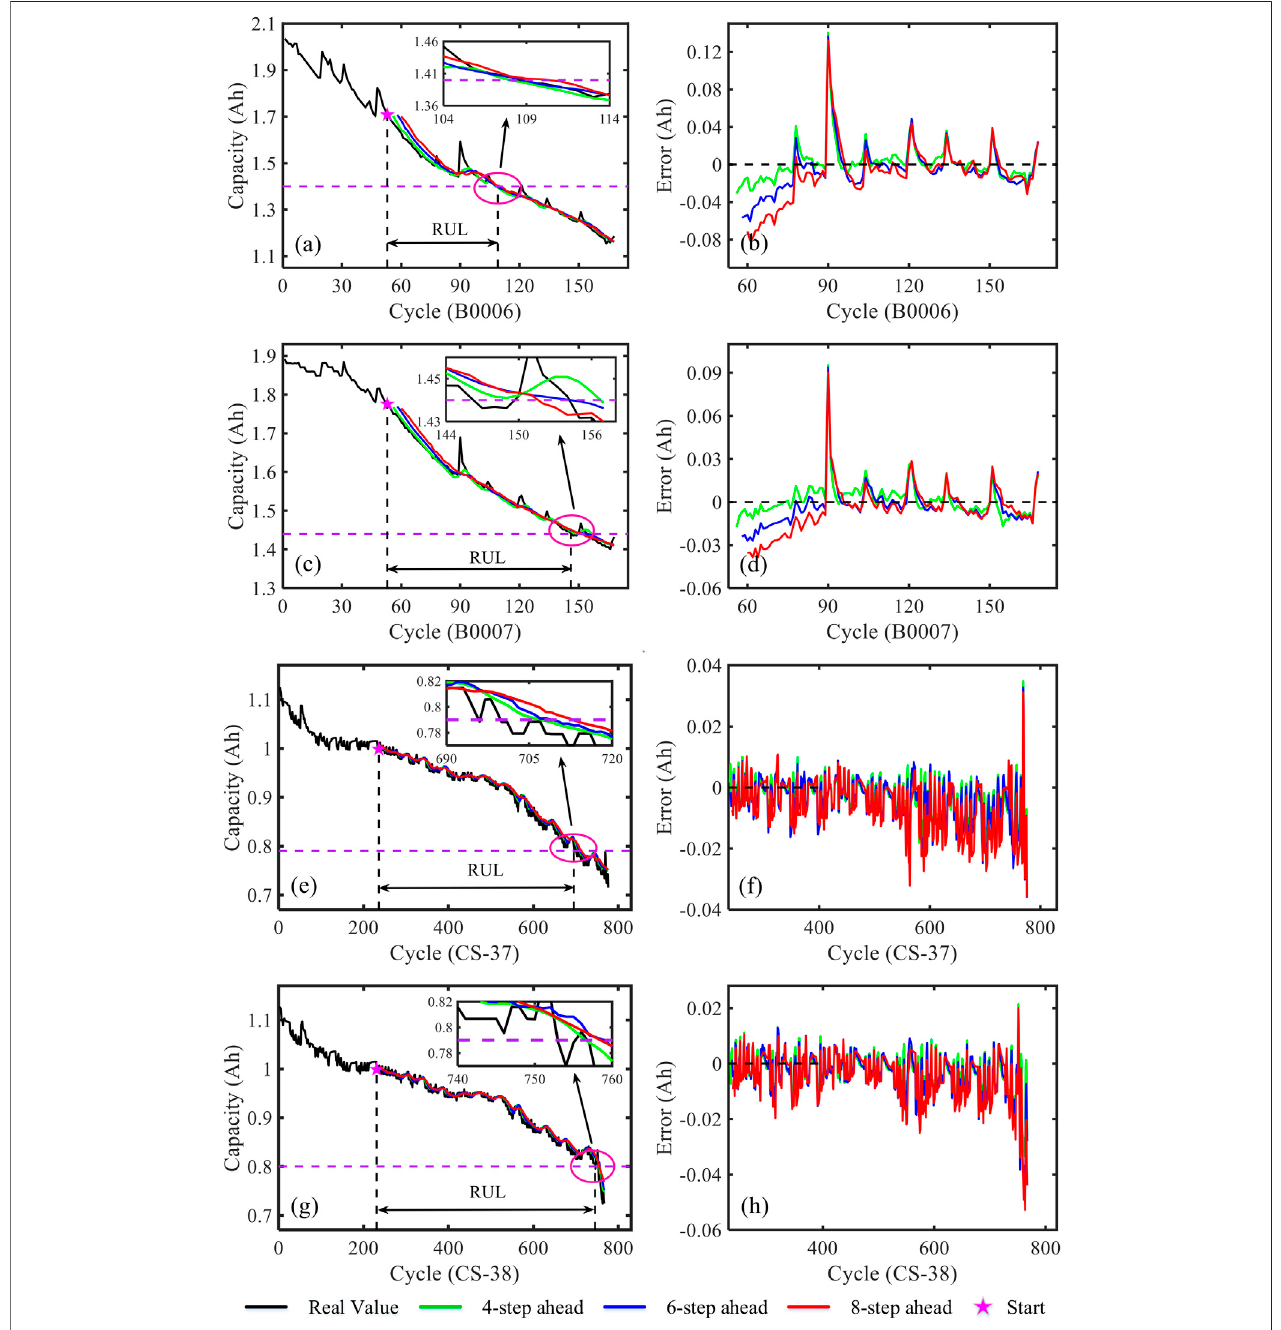
FIGURE7| Prediction results onthemulti-stepprediction inadvance. (A,B) Capacityand erroron B0006. (C,D) Capacity and error onB0007. (E,F) Capacity and error on CS-37. (G,H) Capacity and error on CS-38 of the prediction error.